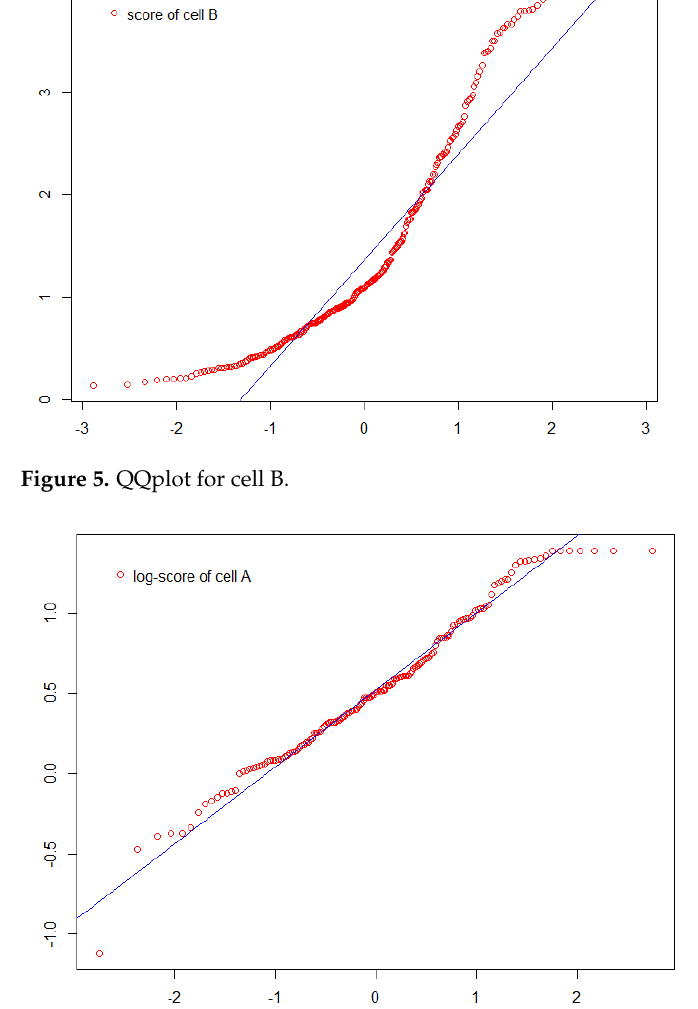
Figure 6. log-QQplot for cell